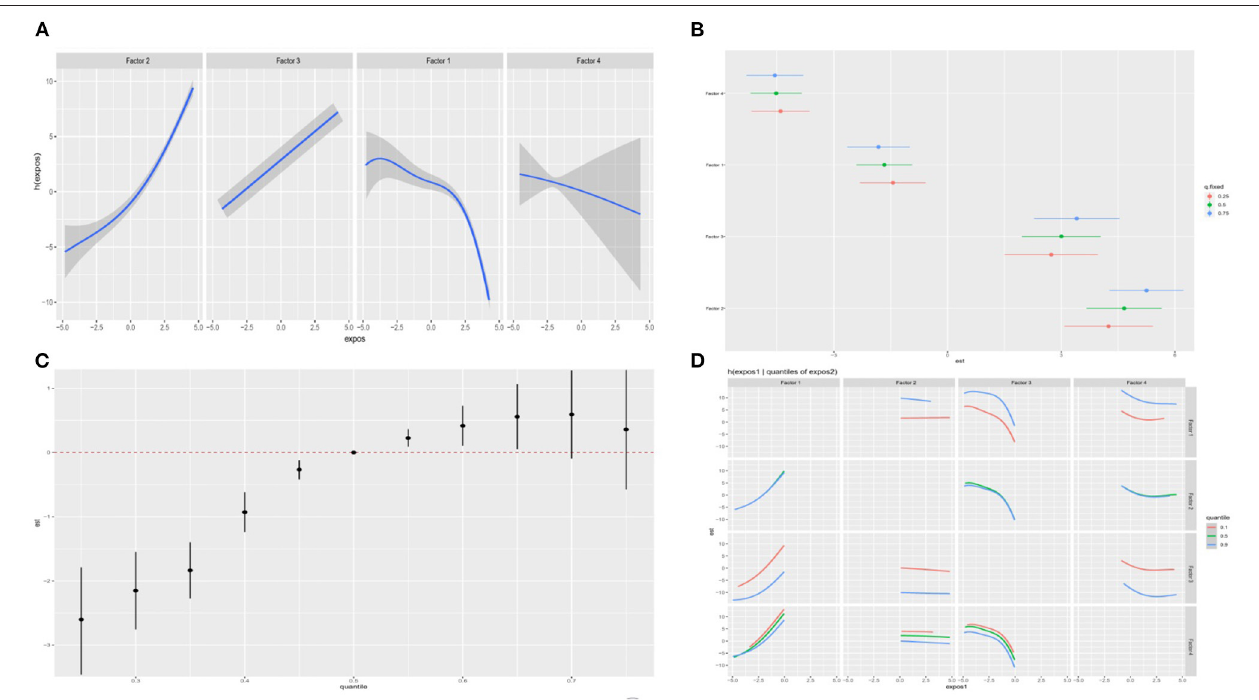
FIGURE 5 | The BKMR model is used to study the association between dietary patterns among women and depression in the elderly. The model is based on age, gender, education level, employment status, smoking status, drinking status, daily energy intake, hypertension and diabetes, and dietary patterns. (A) The single dietary pattern effect (estimates and 95% credible intervals). (B) The univariate nutrient response function of each dietary pattern has a 95% confidence band, and the other nutrients are fixed at the median. (C) Cumulative effects of dietary patterns (estimated value and 95% confidence interval). Compared with other nutrients in the 50th percentile, the nutrients are in a specific percentile (X-axis). (D) Bivariate exposure response function of each two dietary patterns in